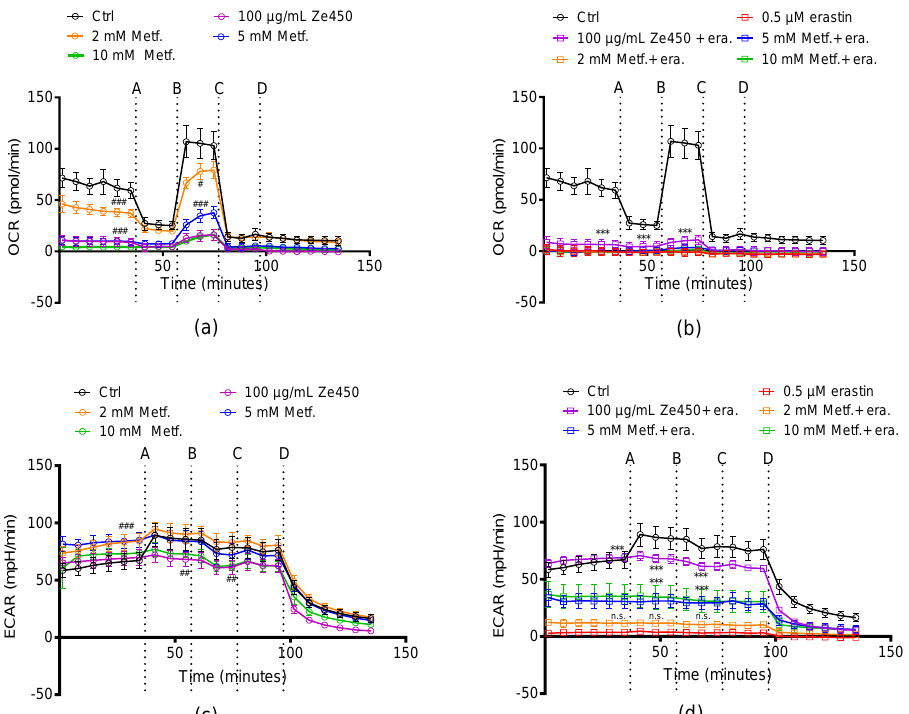
Figure 6. Metformin mediated effects on OCR and ECAR. Data of a representative experiment is depicted, showing OCR and ECAR under basal and oxidative stress conditions. ( a , b ) After 16 h of Ze 450 and metformin treatment ( a ) and challenged with 0.5 μM erastin ( b ), the oxygen consumption rate (OCR) of HT22 was analyzed with a Seahorse XFe96 Analyzer. Data of 5 – 8 replicate wells per condition are given as mean ± SD. C, D: After 16 h of treatment with Ze 450 and metformin ( c ) and challenged with 0.5 μM erastin ( d ) the extracellular acidification rate (ECAR) was determined with a Seahorse XFe96 Analyzer. Data of 5 – 8 replicate wells per condition are given as mean ± SD (port A: oligomycin; port B: FCCP; port C: rotenone and antimycin A; port D: 2-deoxyglucose; *** p < 0.001, compared to erastin-treated control; ### p < 0.001; ## p < 0.01; # p < 0.05 compared to untreated control; ANOVA, Scheffé ’ s test; n.s. not statistically significant).